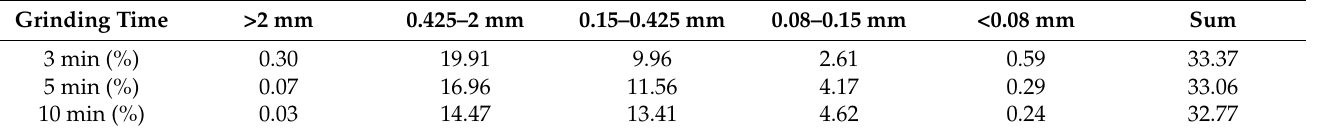
Table 3. Metallic Al contents of different particle sizes of AD after various steel ball grinding